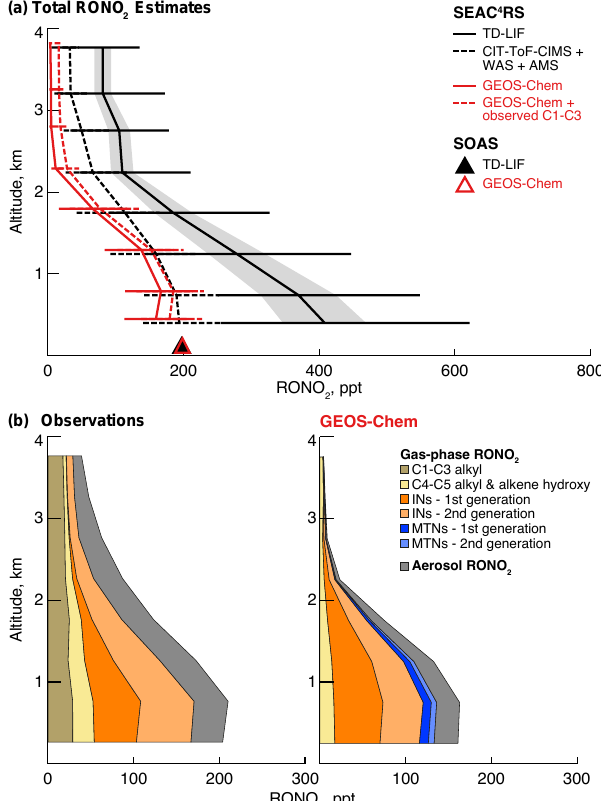
Figure 10. (a) Median vertical profiles of estimated total RONO 2 over the Southeast US during SEAC 4 RS. For the observations, the solid black line indicates the TD-LIF (cid:54) ANs measurements (with gray shading for the measurement uncertainty) and the dashed black line the sum of CIT-ToF-CIMS, WAS, and AMS measurements of individual RONO 2 species (gas-phase and particulate). For the model, the solid red line indicates the total simulated RONO 2 and the dashed red line the sum of the total simulated RONO 2 plus mea- sured ≤ C 3 RONO2 that are not included in the simulation. Trian- gles compare the total RONO 2 during SOAS from TD-LIF (cid:54) ANs and GEOS-Chem. (b) Mean RONO 2 composition from the obser- vations (CIT-ToF-CIMS, WAS, and AMS) and the model. Isoprene nitrates (INs) include first generation (ISOPN, plus ISN1 for GEOS- Chem) and second generation INs (MVKN + MACRN, PROPNN, ETHLN, NISOPOOH, plus DHDN for GEOS-Chem). Monoter- pene nitrates (MTNs) are shown for the model only and include first and second generation contributions. Other gas-phase RONO 2 (yellow, brown) are mainly anthropogenic and do not represent the same species between the model and the